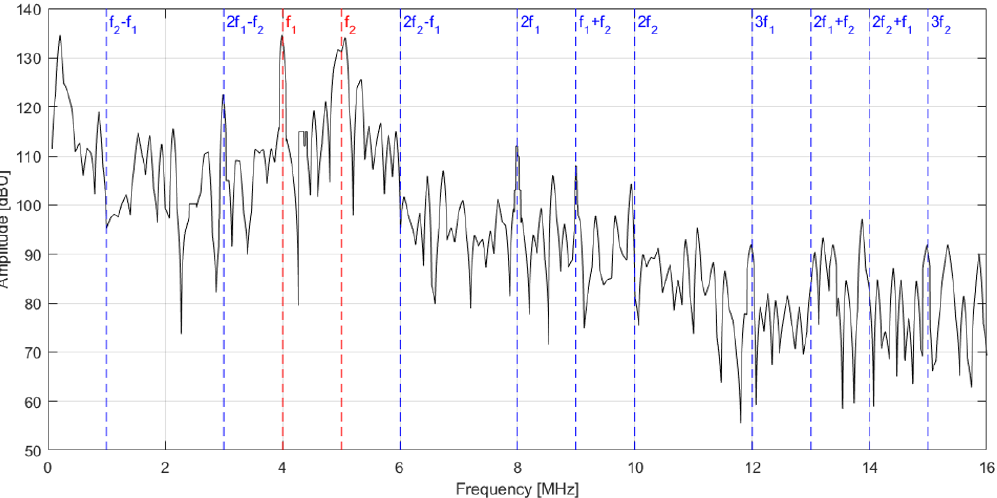
Figure 8. Frequency spectrum, LS-DYNA simulation with excitation frequencies f 1 = 4 MHz and f 2 = 5 MHz.